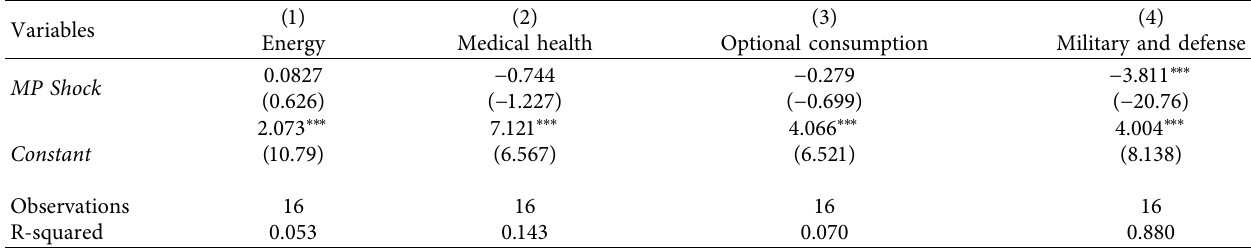
Table 4: Unexpected IEOMP and stock price indices of different industries.